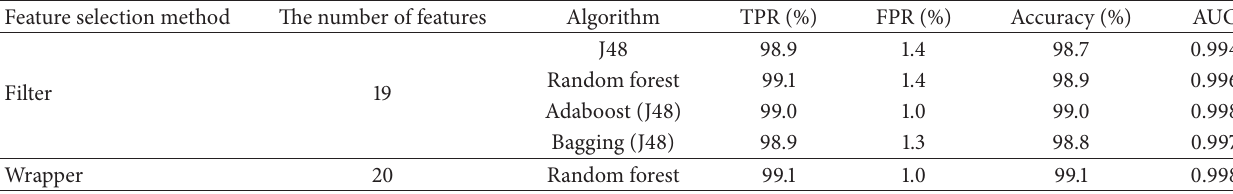
Table 3: Experimental results for all classification algorithms (feature selection from the whole